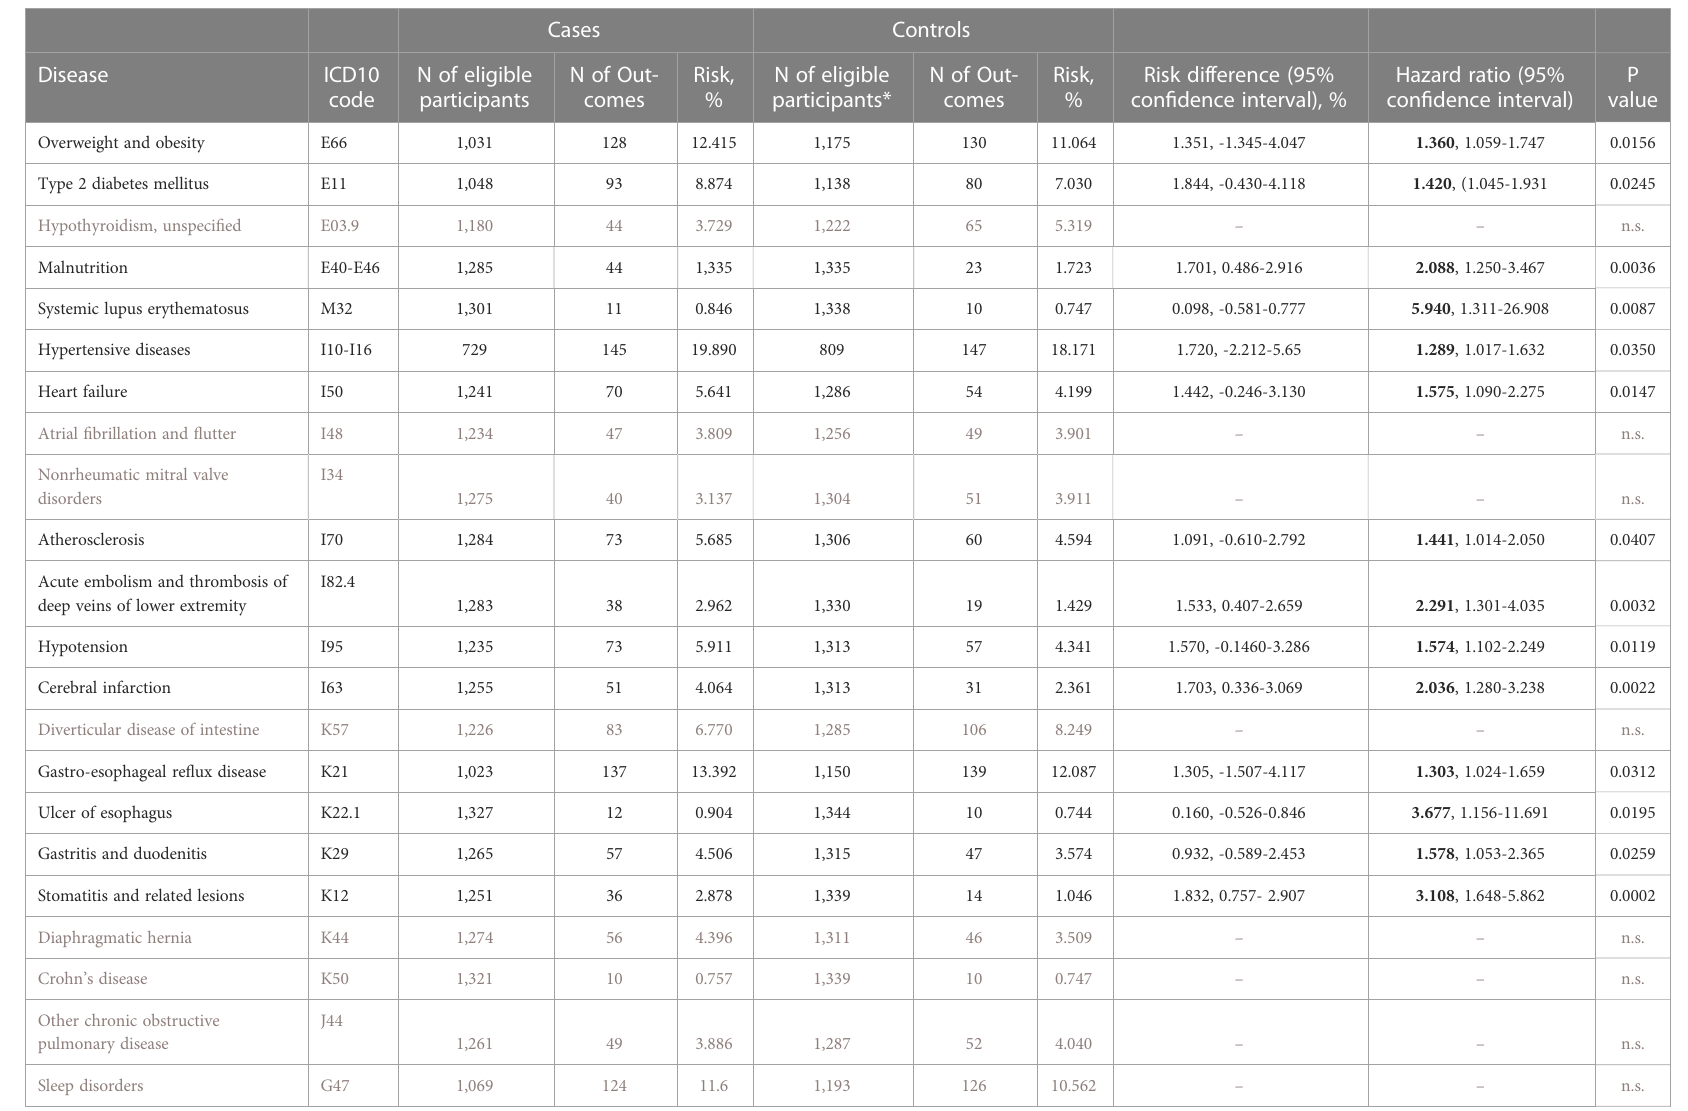
TABLE 2 Sequelae of epidermolysis bullosa acquisita